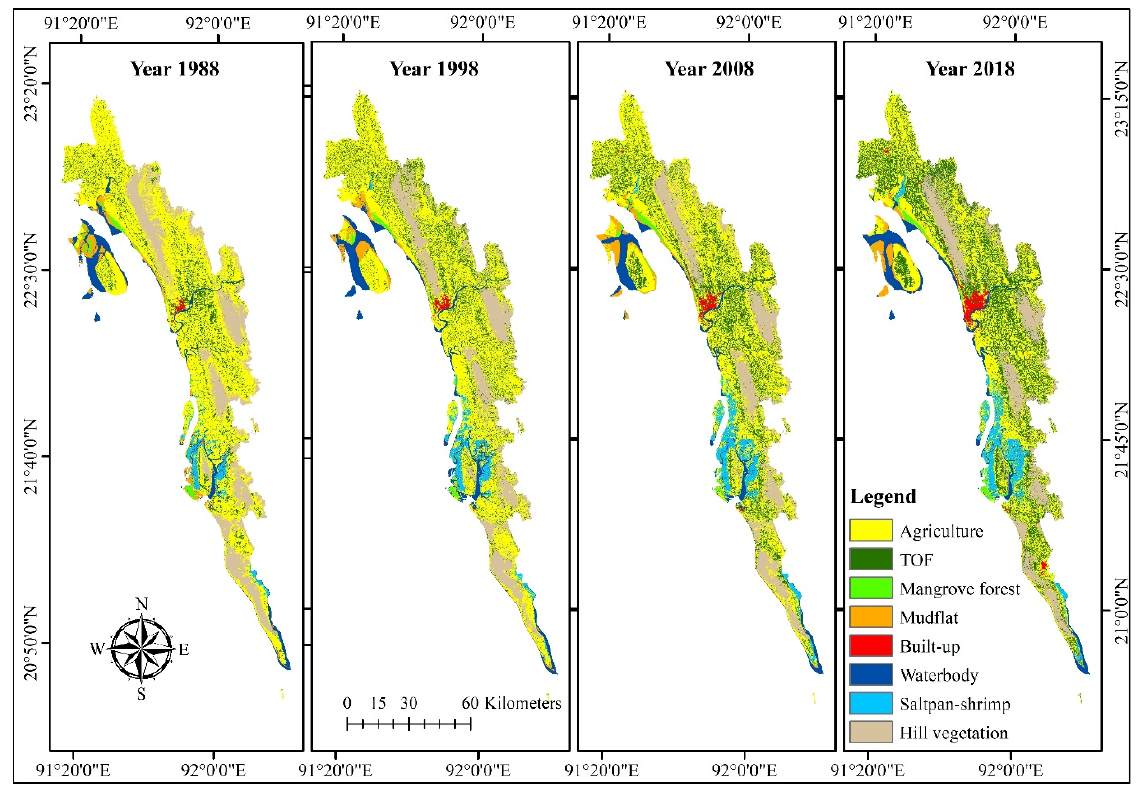
Figure 3. LULC maps of the study area depicting the increasing trend of TOF development.